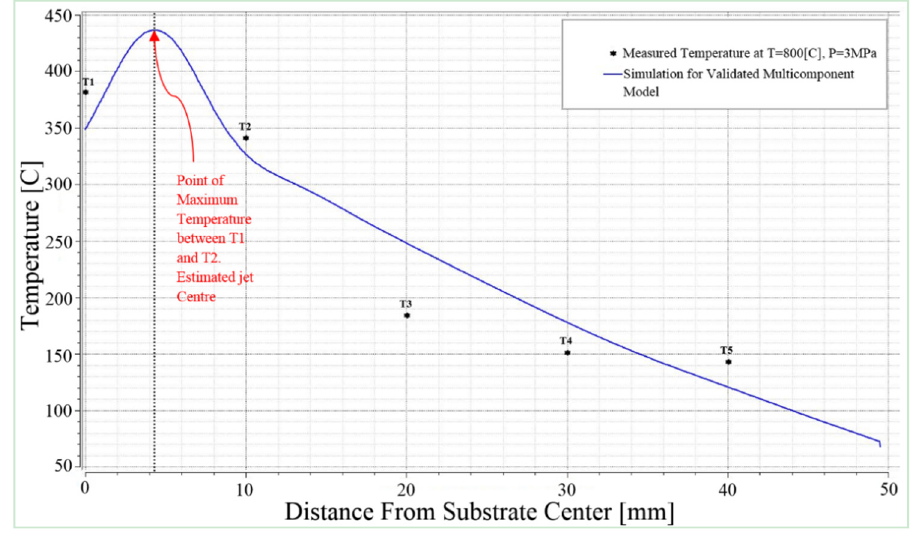
Figure 7. Estimated temperature for cold spray conditions 800 °C and 3 MPa using 3D multicomponent model compared with experimental results for corresponding five